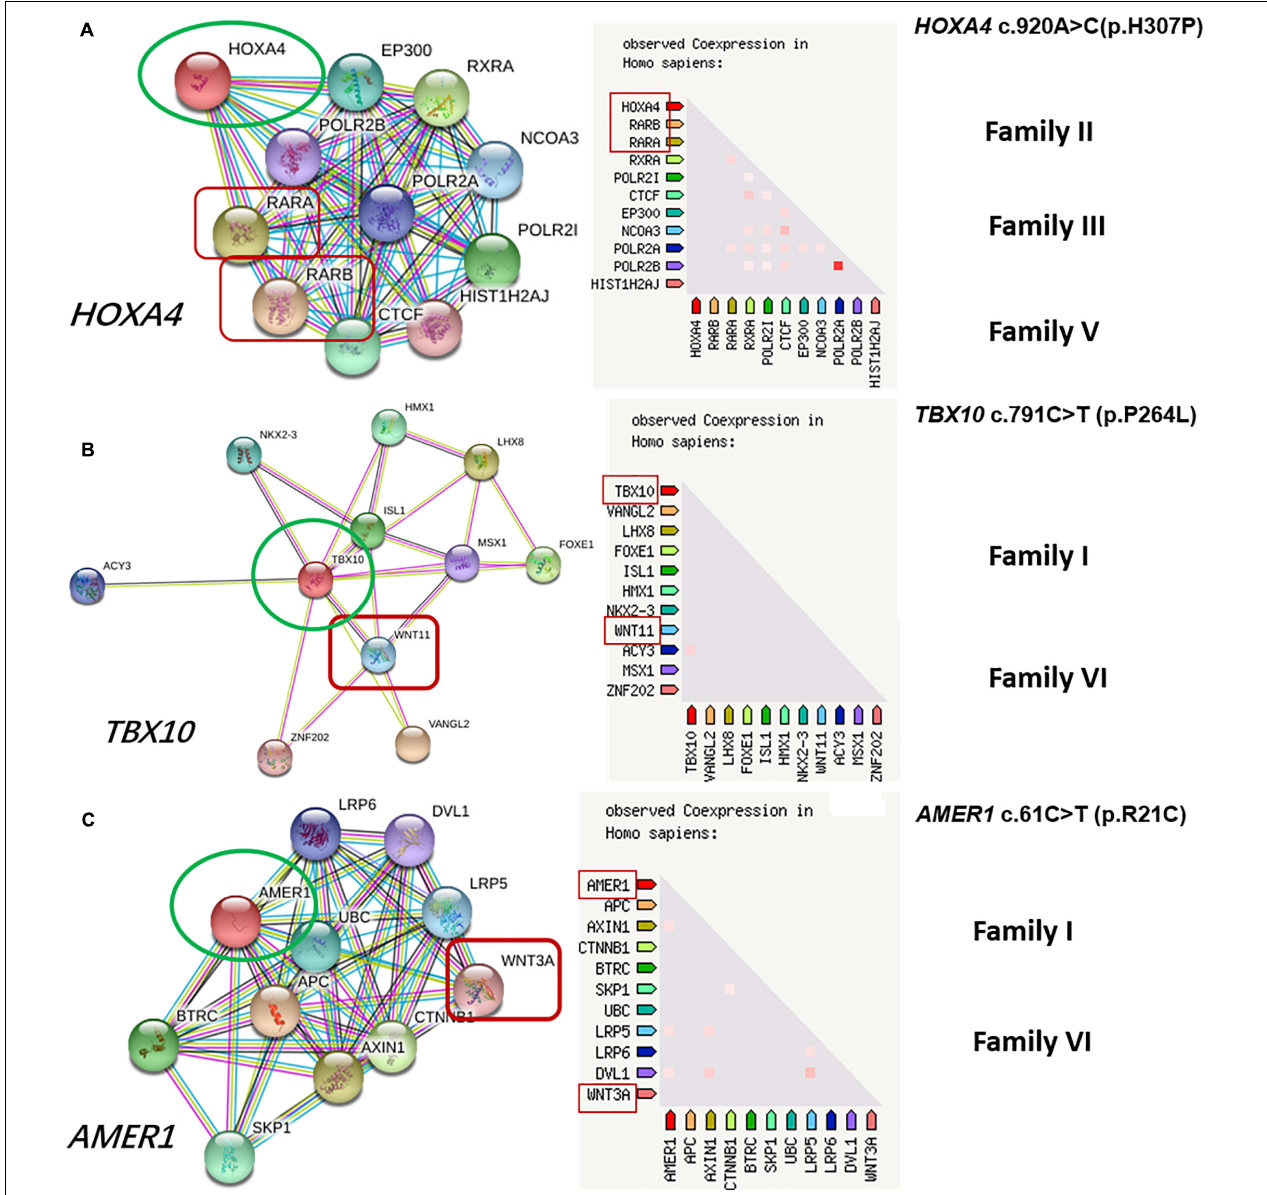
FIGURE 2 | Protein-to-protein interactions of candidate genes with known microtia-atresia associated pathways. (A) HOXA4 directly interacts with RARA of the RA pathway, detected in three families (II, III, V); (B) TBX10 interacts directly or indirectly with WINT11 of the Wnt pathway; (C) AMER1 interacts indirectly with WINT3A of the Wnt pathway. Both genes were detected in Families I and